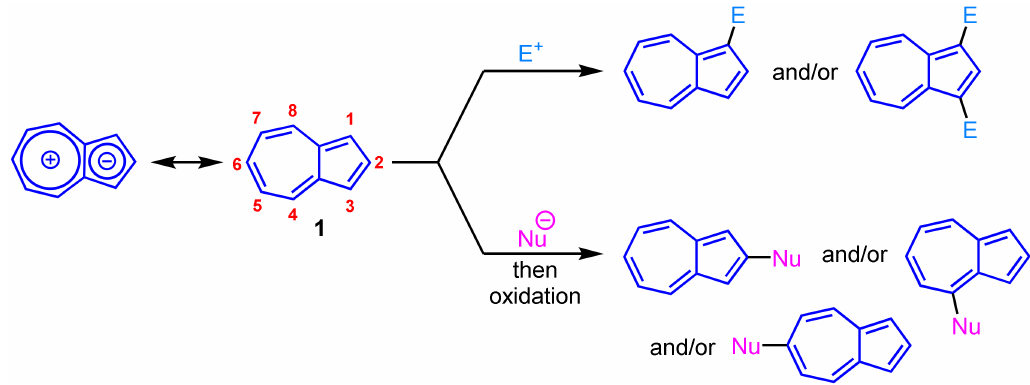
Scheme 1. Resonance structure and general reactivity of azulene ( 1